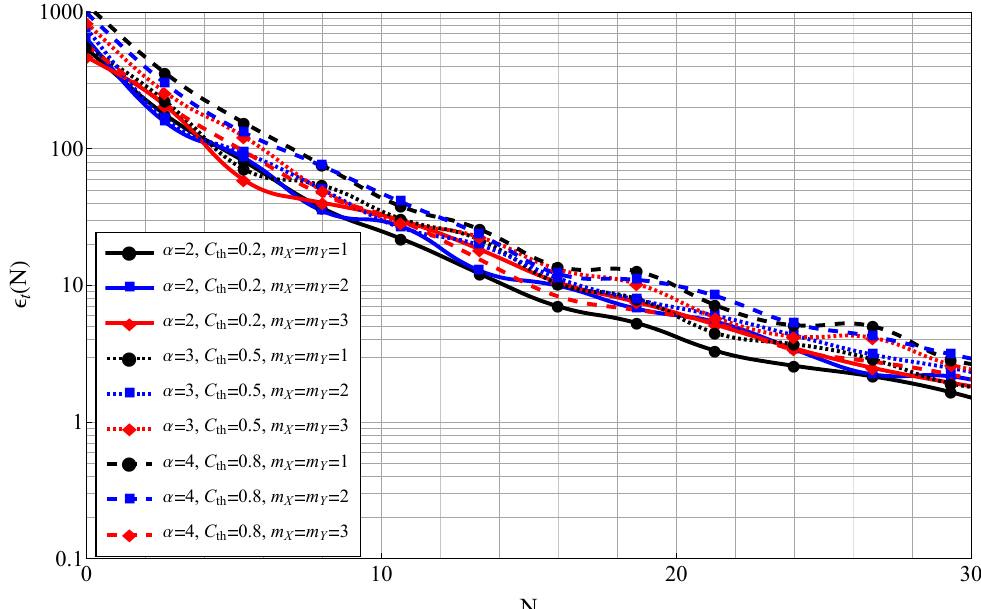
Figure 2. Computational time gain analysis of the derived expression (19) with Ω X = Ω Y = 0 dB, = ¯ γ M = 10 dB and d W / d M